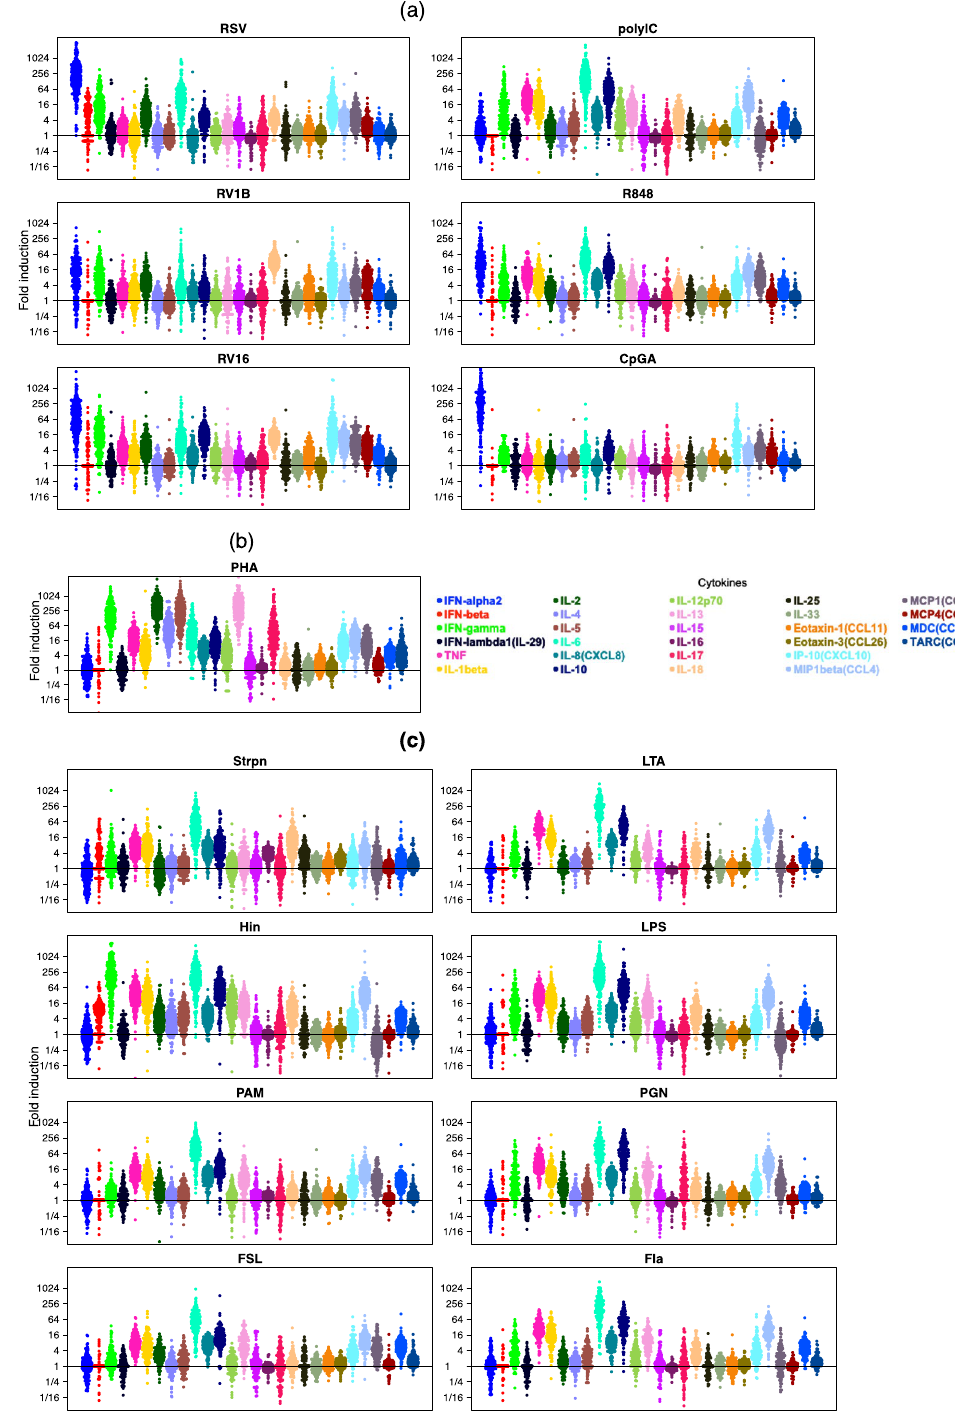
Figure 1. Cytokine response patterns according to stimulus. Fold induction (response/media) of a panel of 28 innate, inflammatory and immune cytokines from PBMCs; each dot represents a child. ( a ) Viral stimuli: RSV, RV1B, RV16, polyIC, R848 and CpGA; ( b ) T-cell stimulus: PHA. ( c ) Bacterial stimuli: Strpn, LTA, Hin, LPS, PAM, PGN, FSL and Fla. This figure was generated using beeswarm package in R (version 3.6.3, https:// www.R- proje ct.